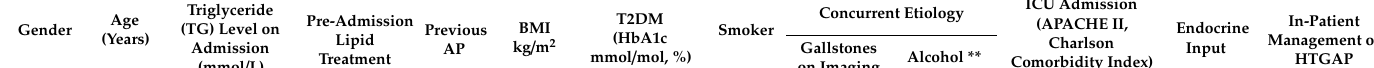
Table 2. HTGAP case series—clinical risk factors, concurrent etiology and management. Cases presented in chronological order of presentation during the study.